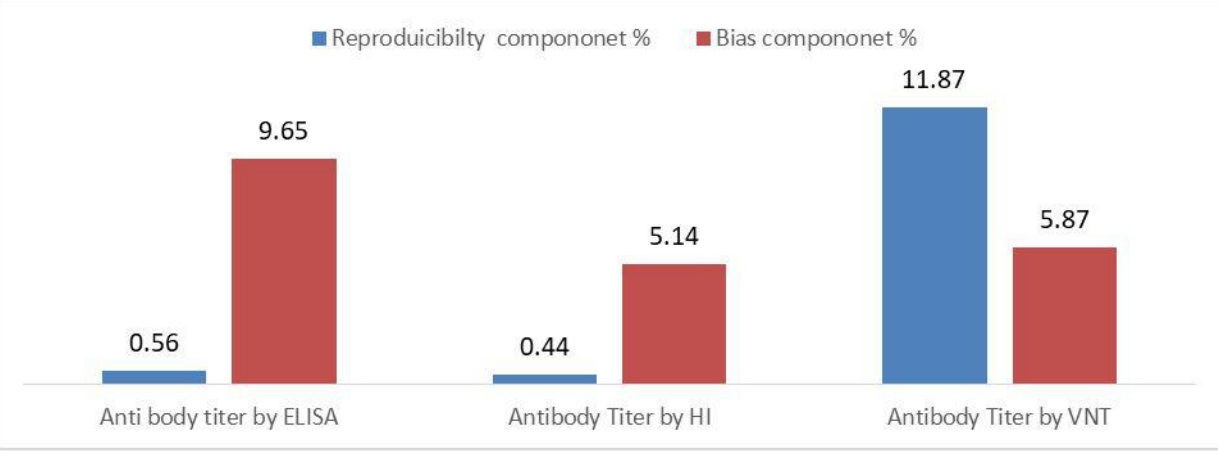
Fig.12: Reproducibility and Bias component for antibody titer by different